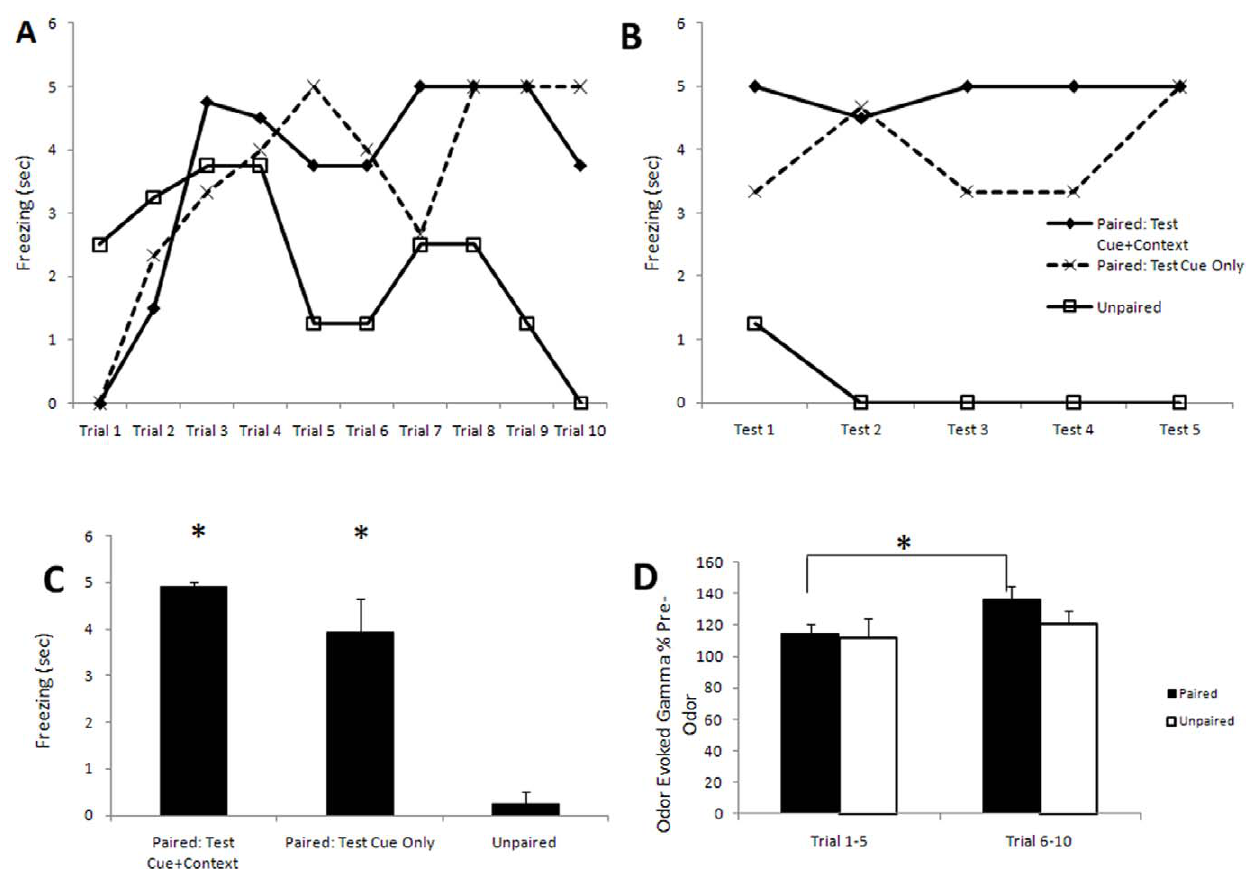
Figure 3. Odor-fear conditioning enhances odor-evoked freezing and odor-evoked gamma oscillations. ( A ) Paired (Test Cue + Context and Test Cue Only) odor-shock animals significantly increased odor-evoked freezing over the course of odor/shock conditioning trials. Furthermore, during odor only tests the following day, ( B ) the Paired animals maintained their odor-evoked freezing response when tested either in the context of the conditioning chamber (n=6) or in a novel context (n=4). Unpaired animals (n=4), however, showed significantly less odor-evoked freezing. During the post-conditioning test, the Unpaired animals show no freezing response to the odor. The legend in Figure B applies also to Figure A. ( C ) Mean level of freezing behavior during the testing session 24 hr post-conditioning across the three groups. ( D ) Power spectrum analysis showed Paired animals had a significant increase in odor-evoked gamma frequency activity over the course of conditioning trials. Odor-evoked gamma (35– 85 Hz) activity was significantly higher on average in the second half of trials compared to the first half in Paired animals. There was no change in Unpaired animals. Asterisks signify significant difference between groups.